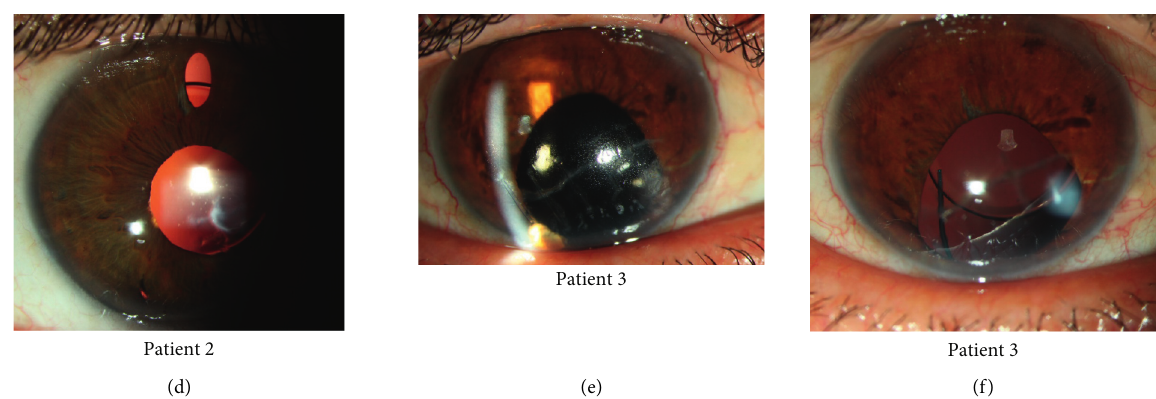
Figure 3: Patient 1: (a) preoperative aphakia with some degree of correctopia and iridodonesis and (b) postoperative slit lamp image; note the 10-0 polypropylene suture visible under the conjunctiva with round ends at 1 and 7 o’clock. Patient 2: (c) preoperative aphakia with remnants of capsular bag and iris sphincter damage and sutured corneal wound and (d) postoperative image with a well-centered IOL as seen through the upper iridotomy. Patient 3: (e) preoperative aphakia, corneal scar, and lower iris sphincter damage with peripheral anterior synechia and (f) well-centered IOL postoperatively. Note the vertical orientation of the lower haptic confirming